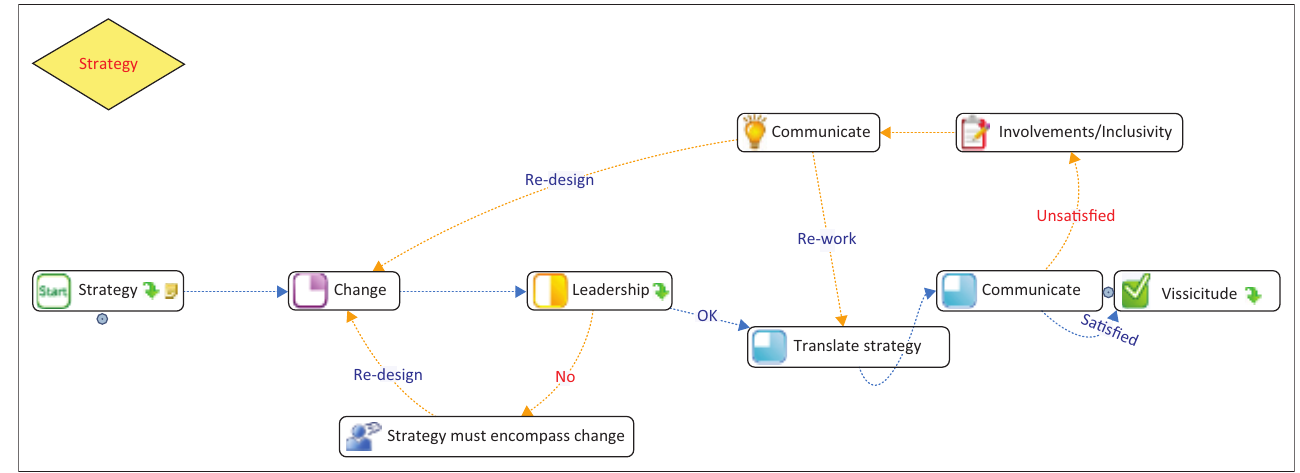
FIGURE 1: Relational map